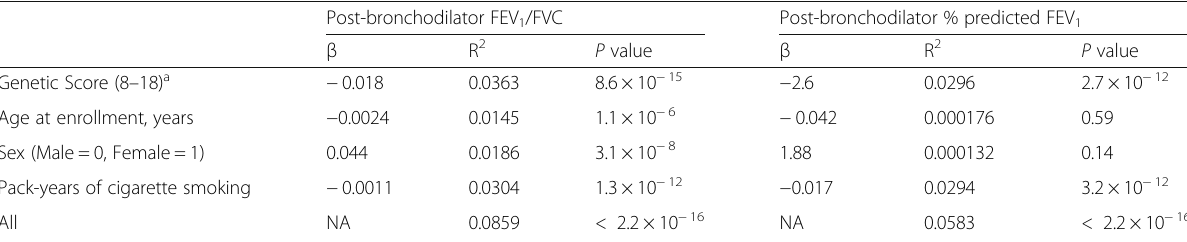
Table 4 Prediction Models for Post-bronchodilator Lung